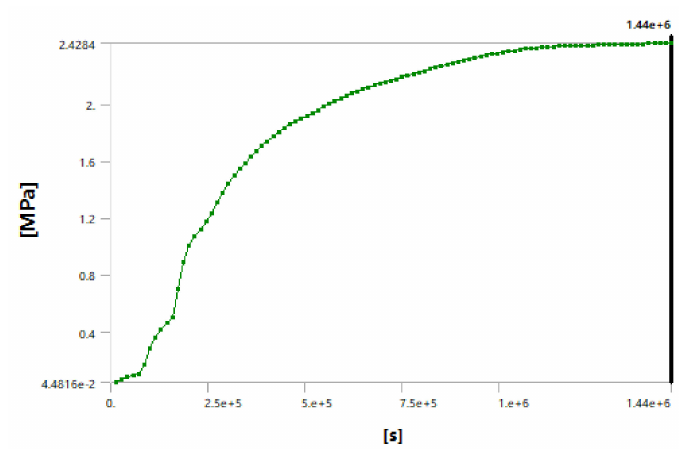
Figure 9. Stress–time curve for the surface between the hard rock layer and the cutter